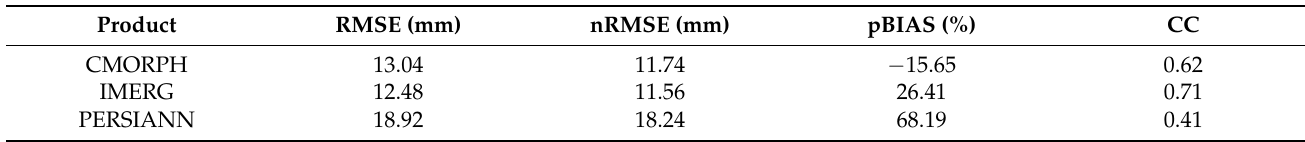
Table 2. Performance metrics of monthly data of the satellite-based precipitation products relative to rain gauges over the UAE.